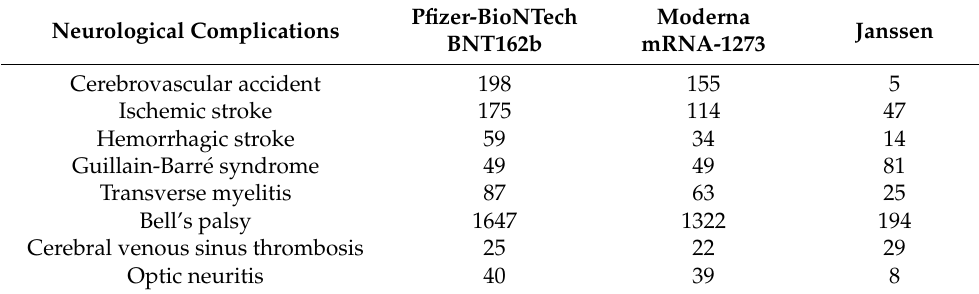
Table 3. Vaccine adverse events reporting system (VAERS) results (as of 27 August